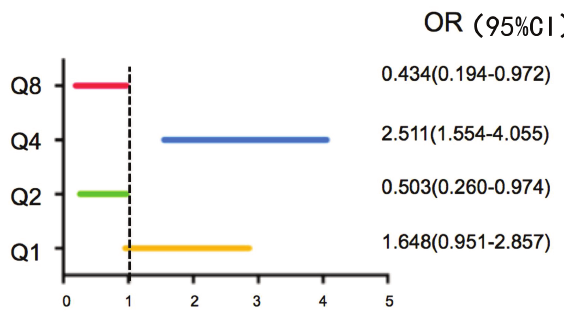
Figure 2: Association between Risk Grade and Risk Factors accor- ding to the IOF Test Multivariate unconditional logistic stepwise regression analysis was used (forward-step method, p < .1). Q1: Have you ever broken a bone after a minor fall as an adult? Q2: Have either of your parents been diagnosed with osteoporosis or broken a bone after a minor fall (from standing height or less)? Q4: After the age of 40 years, have you lost > 3 cm in height (just over 1 inch)? Q8: For women over 45: Did your menopause occur before 45